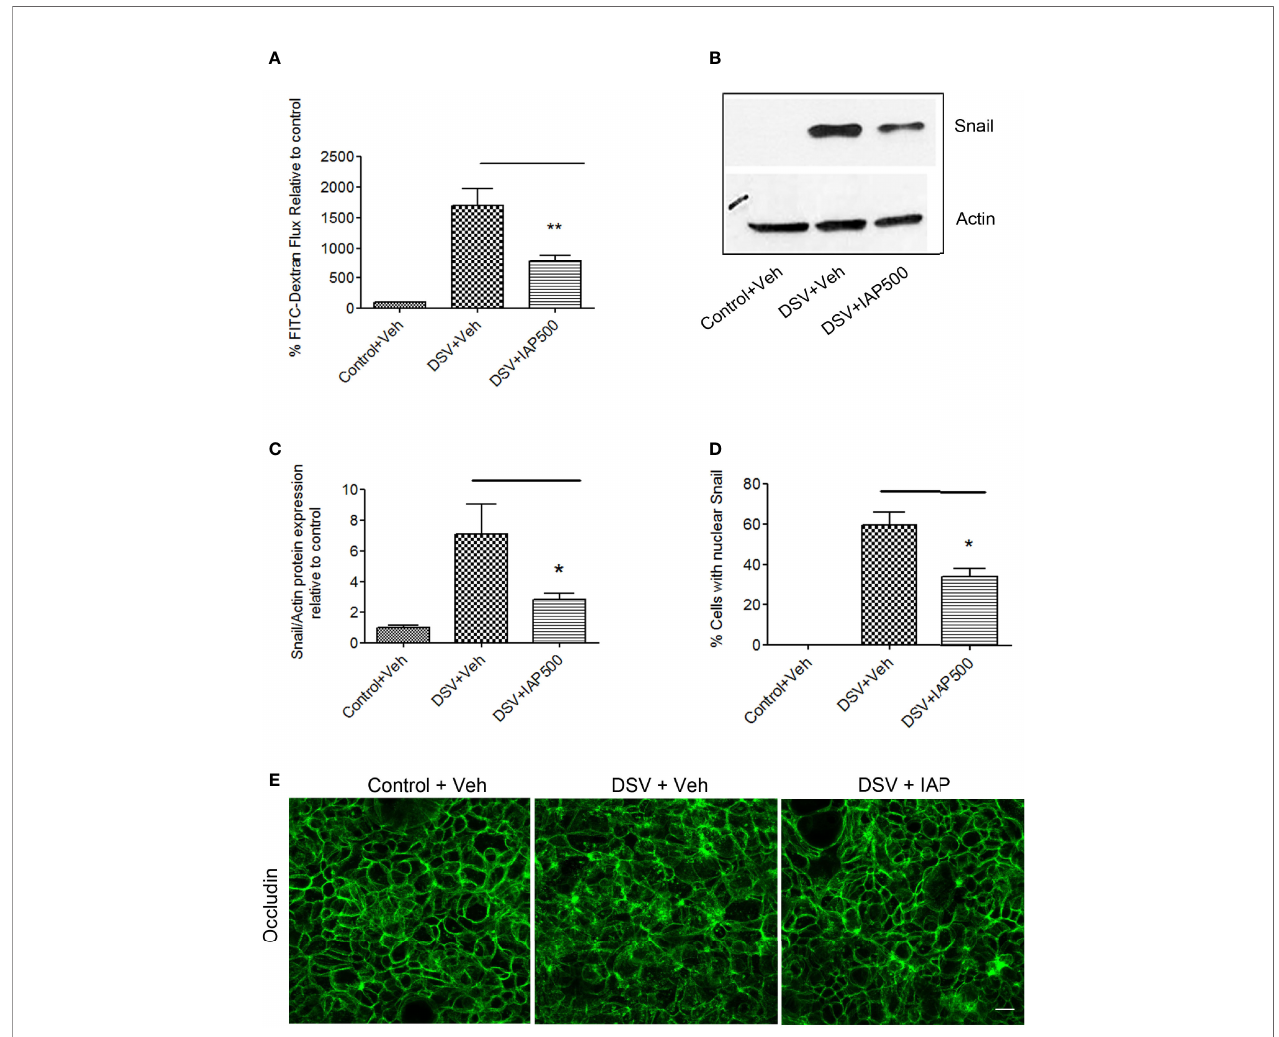
FIGURE 5 | Intestinal Alkaline Phosphatase inhibits DSV-induced permeability by inhibiting snail. Polarized Caco-2 cells were pre-treated with IAP (500 U/ml) at the apical and the basolateral surface for 24 hours prior to challenge with DSV. (A) FITC-Dextran was added to the cells apically after 24 hours infection with DSV. Fluorescence was measured by taking out 100 m l medium from the basolateral surface after 1 hr. incubation. Graph represents Mean ± SEM of % FITC- fl ux compared to uninfected control cells from at least 3 independent experiments. **p < 0.01. (B) Snail protein expression was analyzed by Western blotting in cells pre-treated with or without IAP followed by infection with DSV. The solution in which IAP was supplied was used as a Vehicle control. Actin was used as a loading control. (C) Quanti fi cation of Western blot for detection of snail. Graph represents Mean ± SEM of ratio of Snail/Actin and values were normalized to control from at least 3 independent experiments. *p < 0.05. (D) Cells were pre-treated with or without IAP followed by infection with DSV. Cells were fi xed with 4% paraformaldehyde and probed by immuno fl uorescence for snail staining as described in Materials and Methods. Graph represents quanti fi cation of % cells showing nuclear staining of snail in control, DSV or DSV+IAP treated groups. Values represent Mean ± SEM from three independent experiments. *p < 0.05. (E) Cells were pre-treated with or without IAP followed by infection with DSV. Cells were fi xed with 4% paraformaldehyde and probed by immuno fl uorescence for occludin staining as described above. Images were collected as Z-stacks that were compressed at the end to generate the fi nal images. Scale